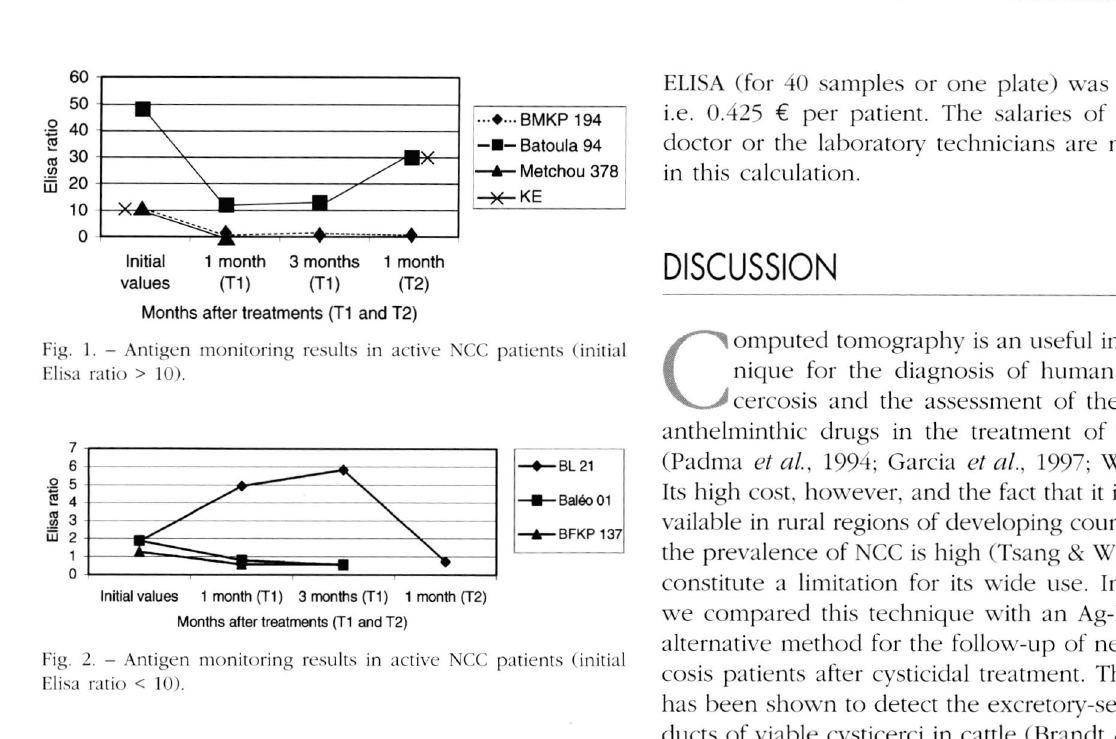
Fig. 2. - Antigen monitoring results in active NCC patients (initial Flisa ratio <